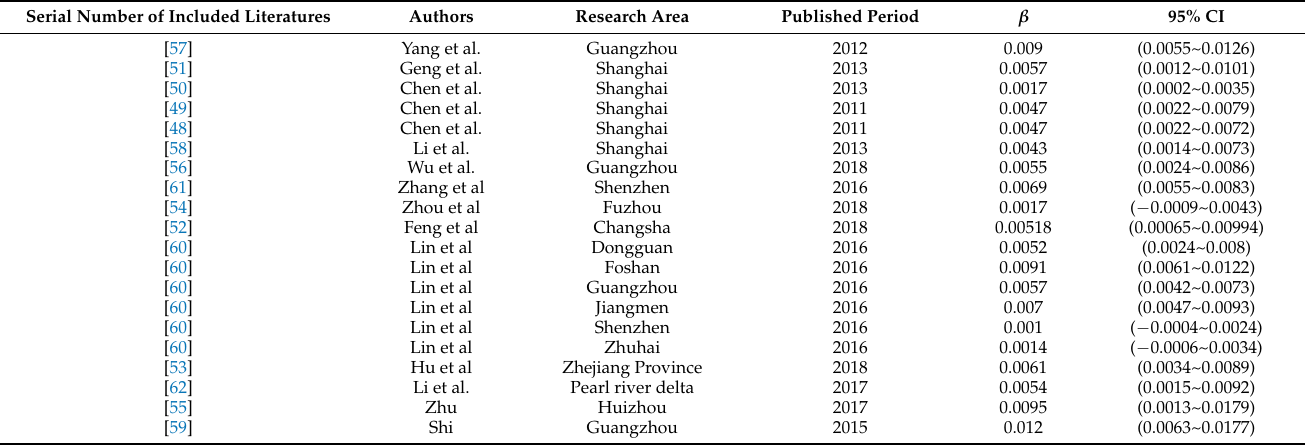
Table 1. Information of 15 peer-reviewed articles with the relationship coefficient of exposure to reaction (i.e., β ) used for the